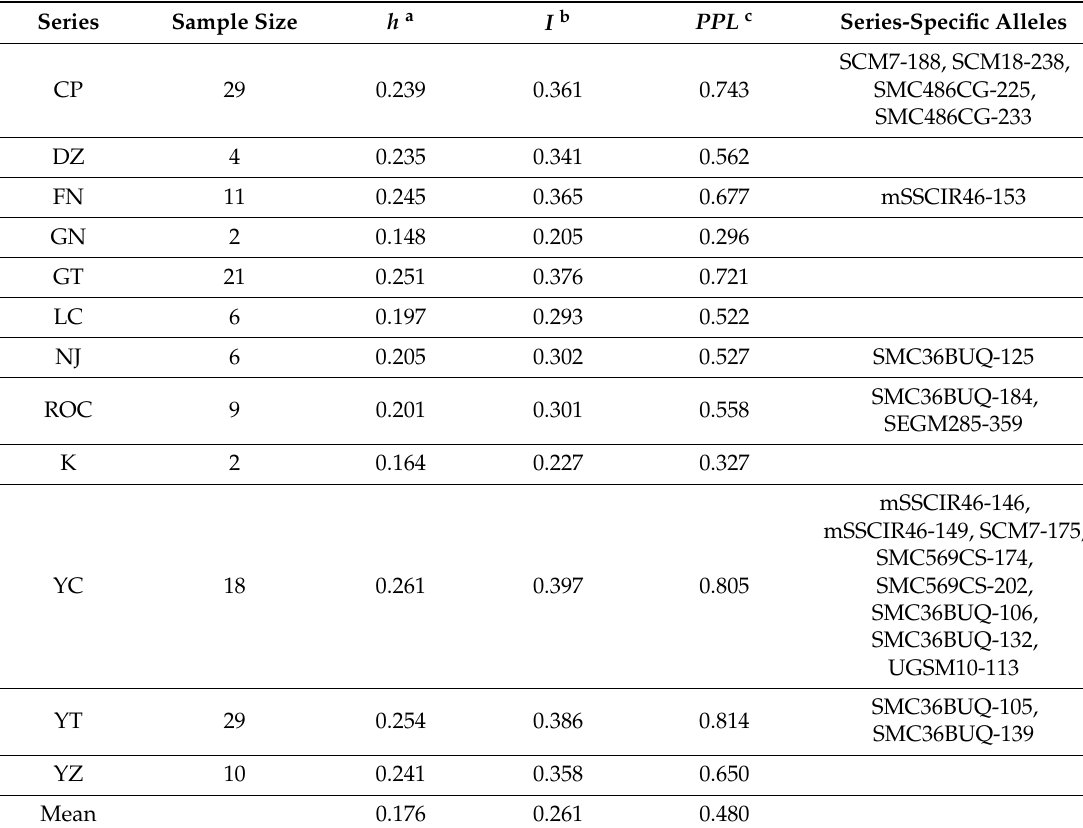
Table 4. Gene diversity, Shannon’s information index, percentage of polymorphic loci and series-specific alleles of di ff erent